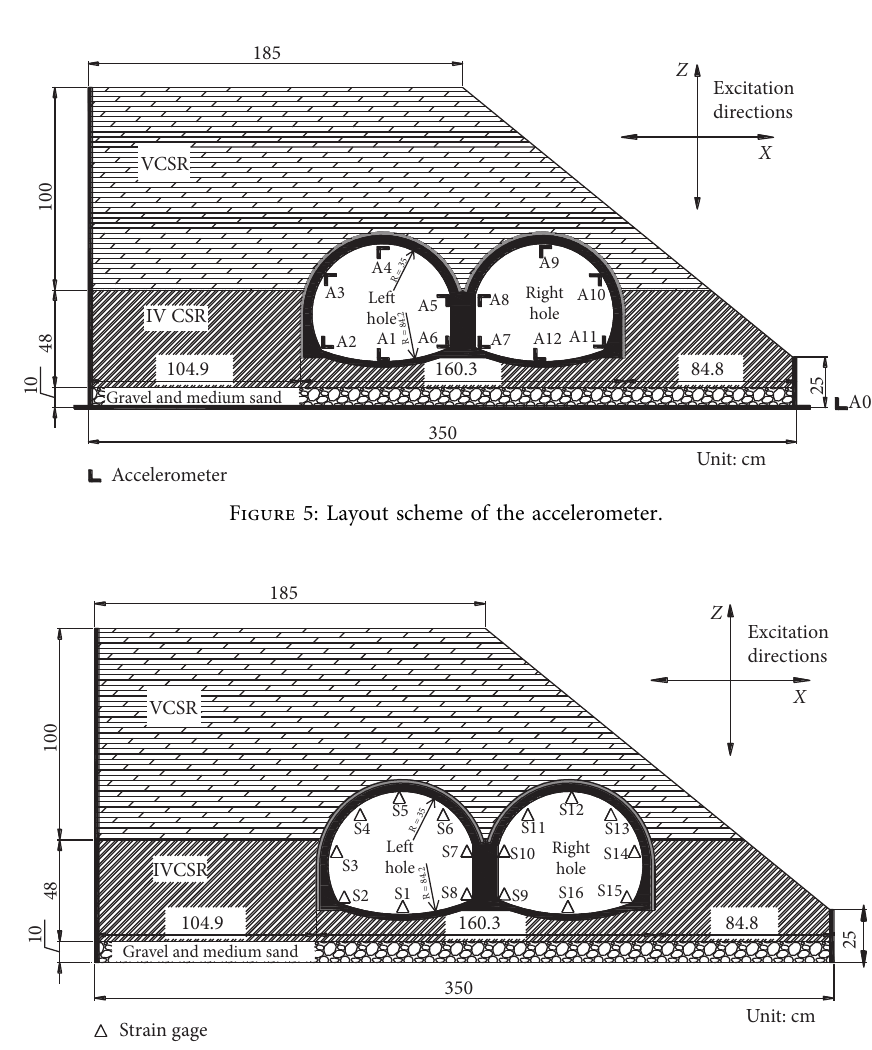
Figure 6: Layout scheme of the strain